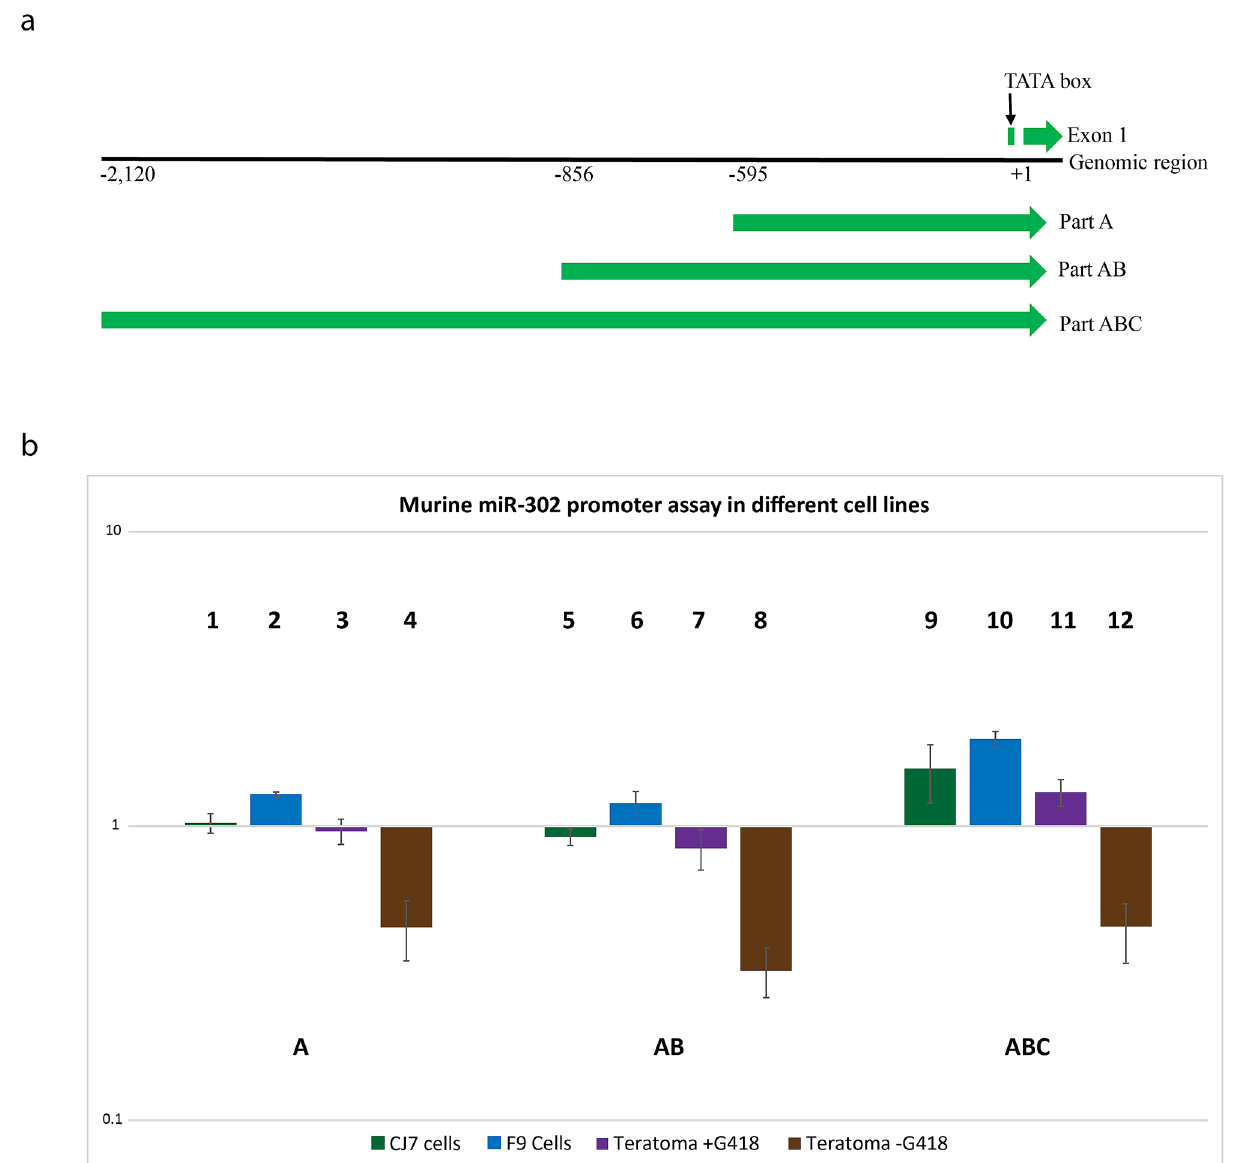
Figure 4. Functional analysis of the 2.1 kb upstream genomic region of the mmu-miR-302 host-gene. (a) Schematic representation of the 3 regions analyzed: part A (+ 45 to -595), part AB (+ 45 to −856), and part ABC (+ 45 to −2120). ( b ) Comparison of the promoter/enhancer activity of the three regions in different cell types, normalized to the expression level of the promoter-less reporter. The baseline expression level is relatively high, which allows to test for repressor activity, which appears as values below 1. F9 cells (2, 6, 10) show consistently a higher reporter expression than ES cells (1, 5, 9) or teratoma derived stem cells selected for miR-302 host-gene expression (teratoma + G418: 3,7,11). If selection is stopped, teratoma derived cells start to differentiate and lose reporter expression (teratoma -G418: 4, 8, 12). Bars represent mean ± SD, n = 3. Statistical comparison of data: